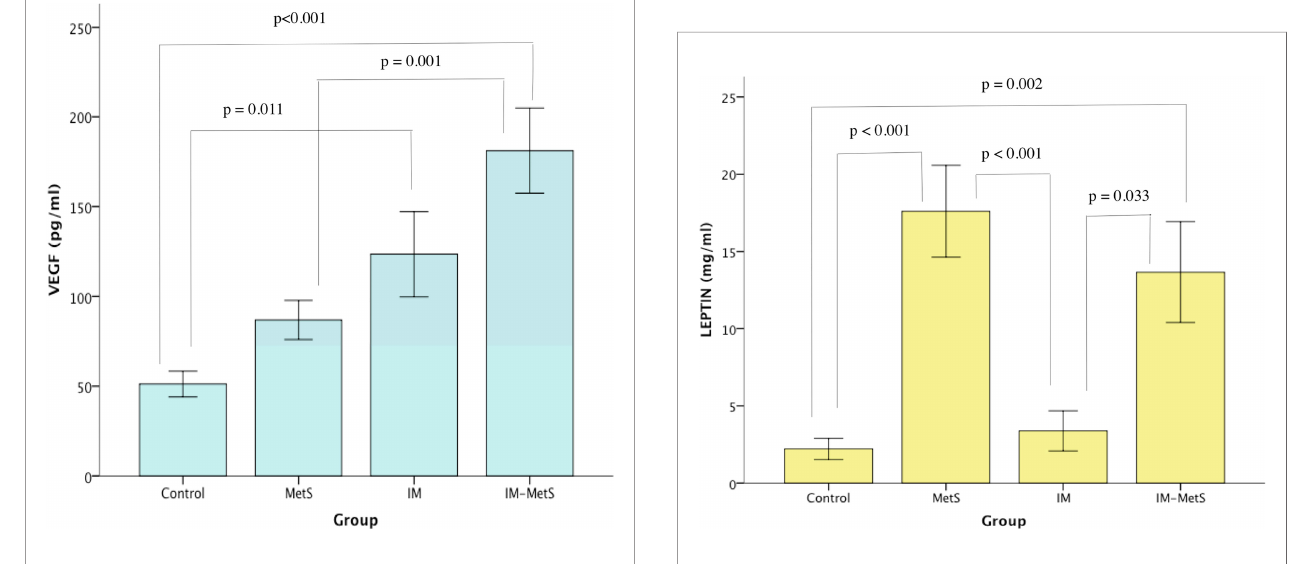
FIGURE 1 | VEGF levels in patients and control. FIGURE 2 | Leptin levels in patients and